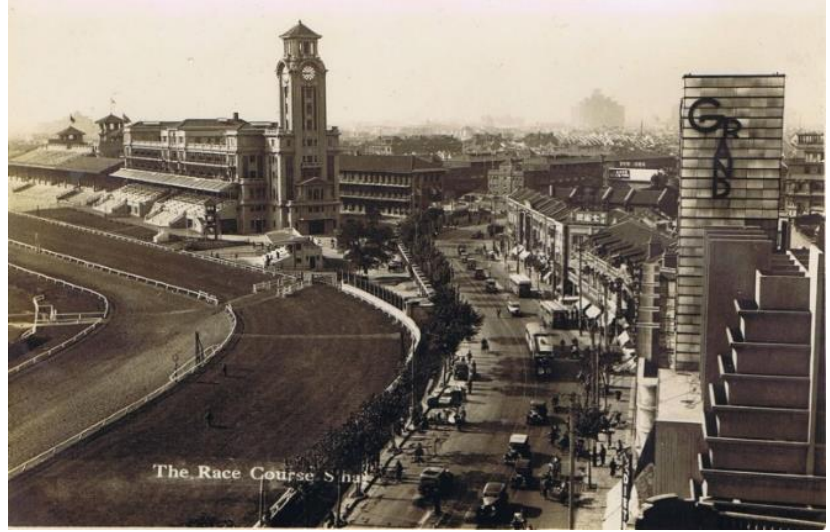
Figure 14. The racecourse with the Shanghai Race club and Grand Theatre, viewed from the Park